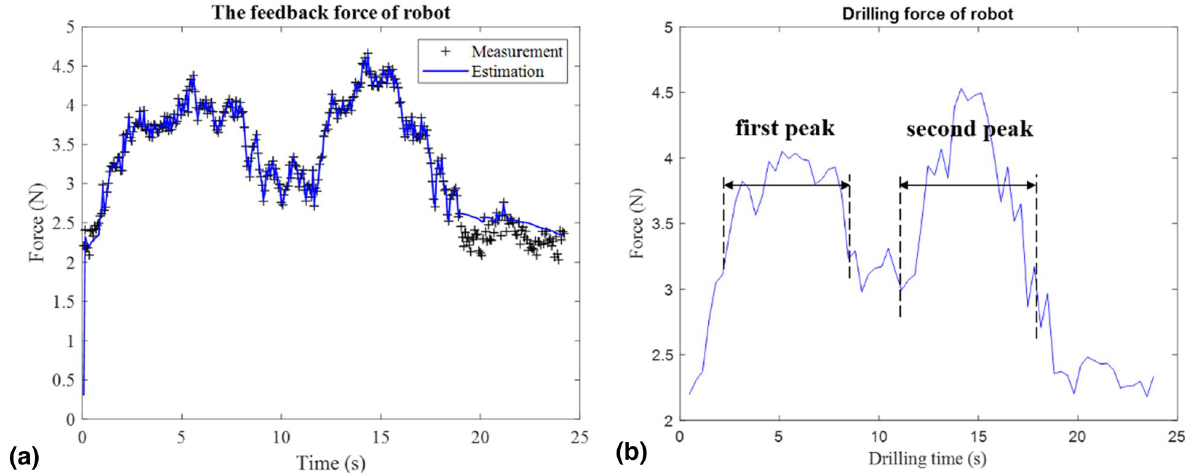
Figure 3. The drill force: ( a ) the feedback force by Kalman filter; ( b ) the force information during